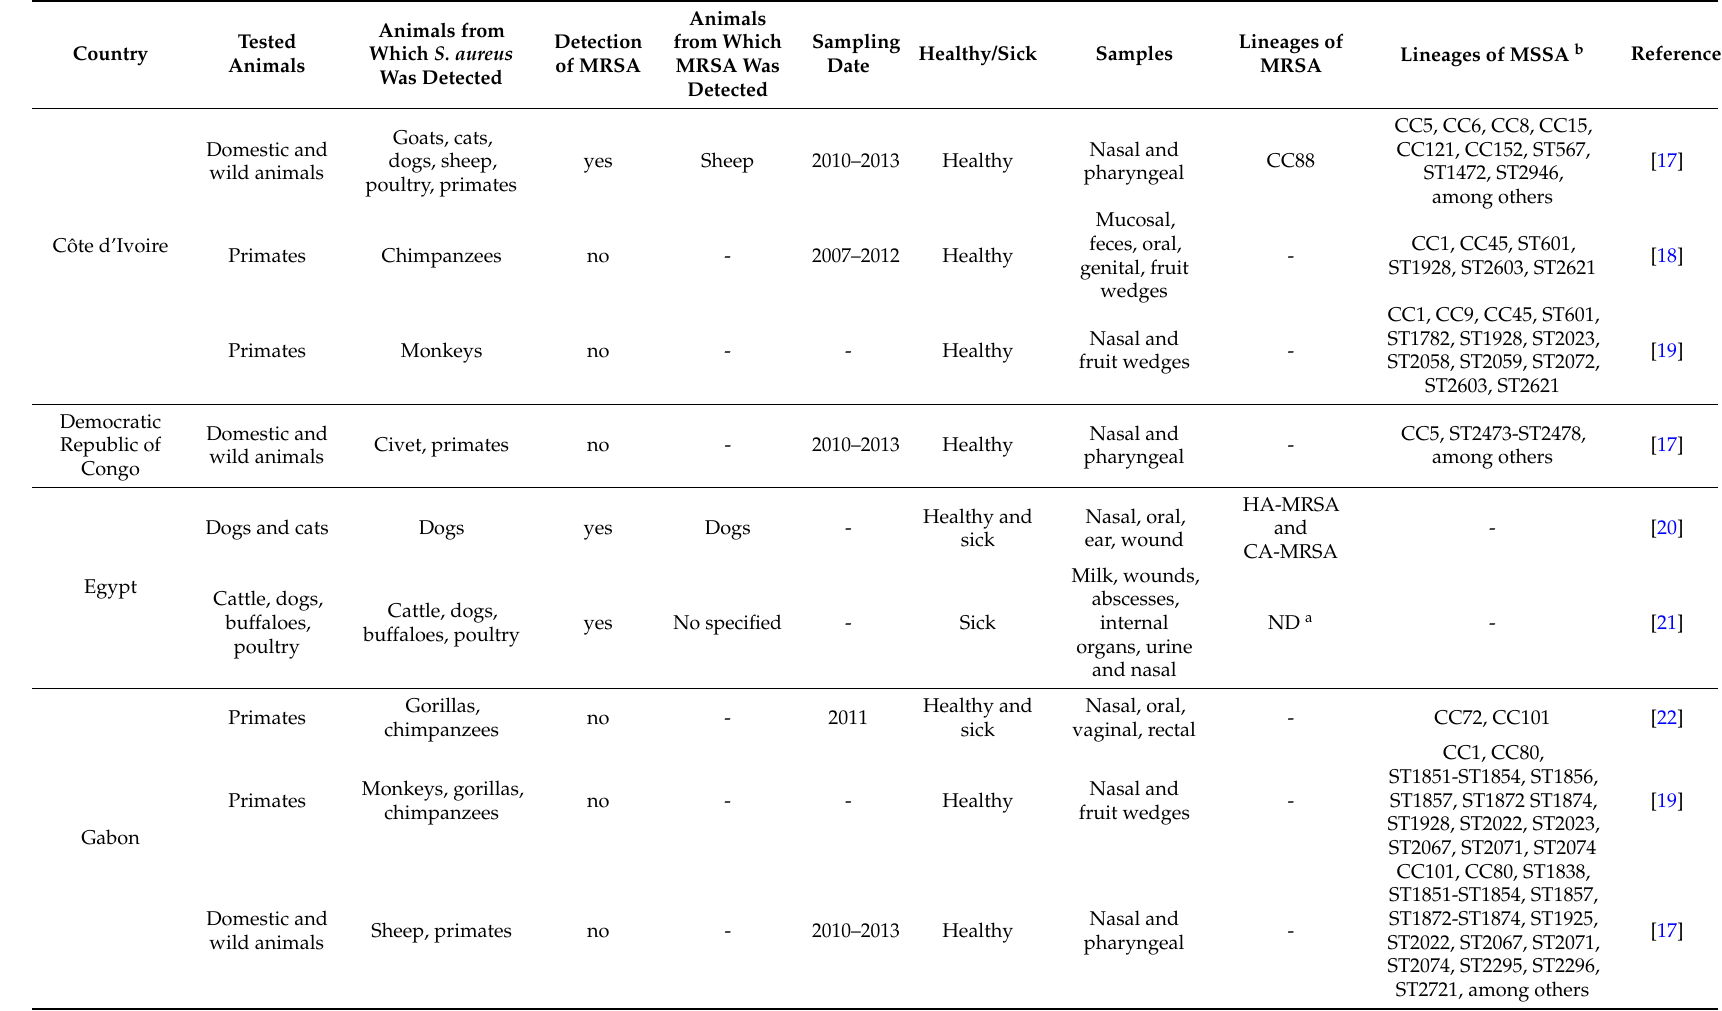
Table 1. Distribution and clonal lineages of S. aureus detected in animals in the African